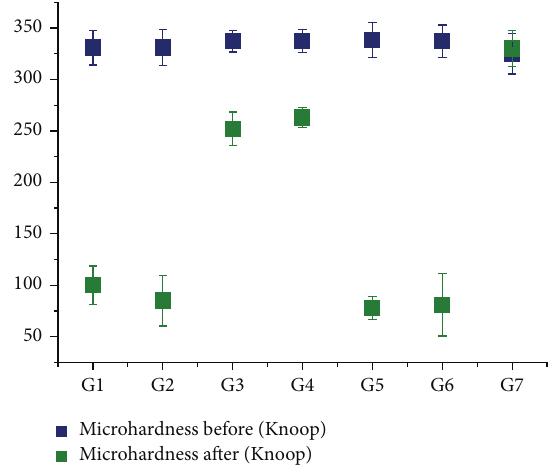
Figure 3: It exhibits the box plot comparing the microhardness before and after the action of fruit juice plus soy ( 𝑛 = 70 ). (G1: AdeS Grape, G2: AdeS Apple, G3: Solly’s Grape, G4: Solly’s Apple,